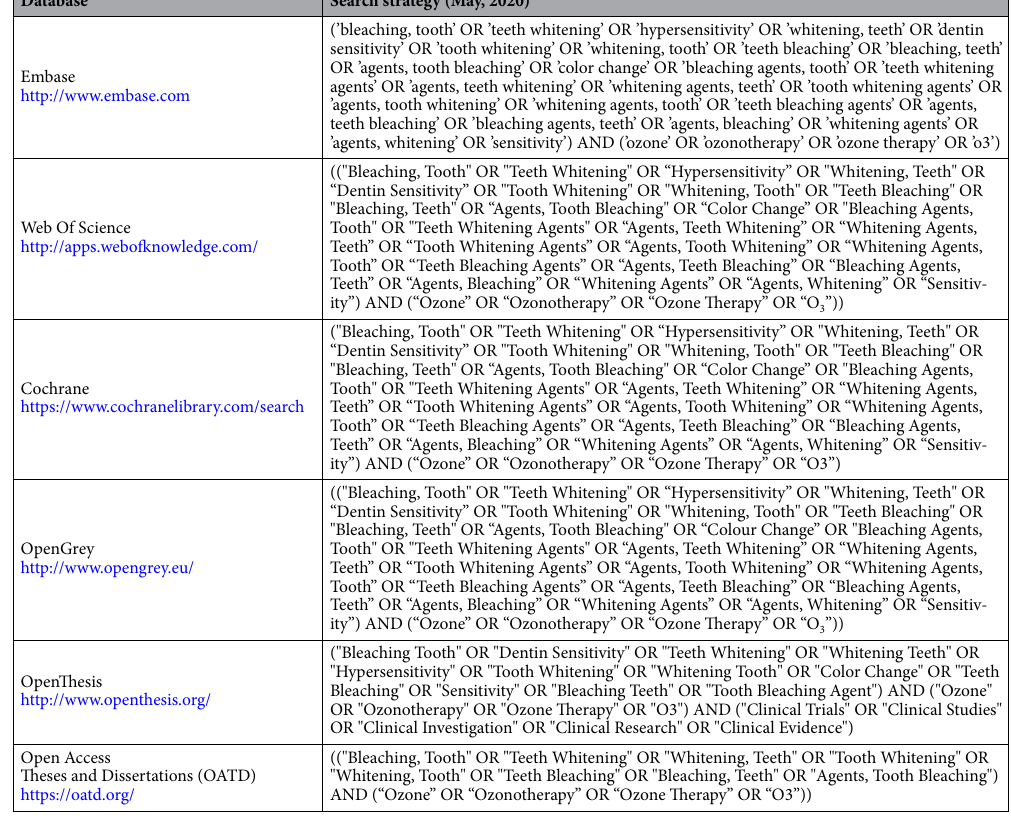
Table 1. Strategies for database